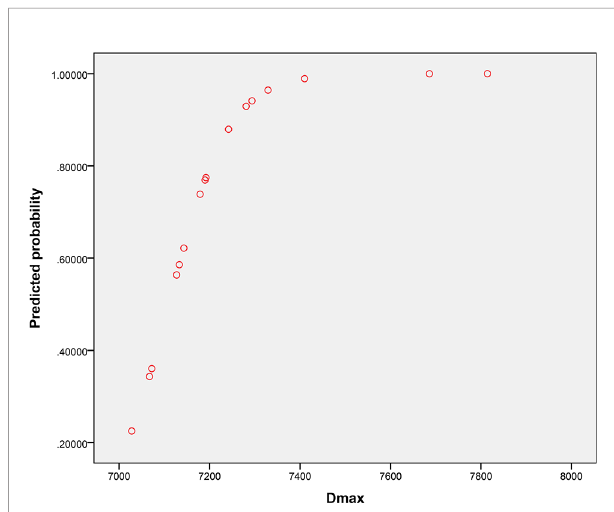
FIGURE 5 | Predictive probability graph of radiation-induced optic neuropathy incidence with increasing maximum doses applied to the neuro- optic